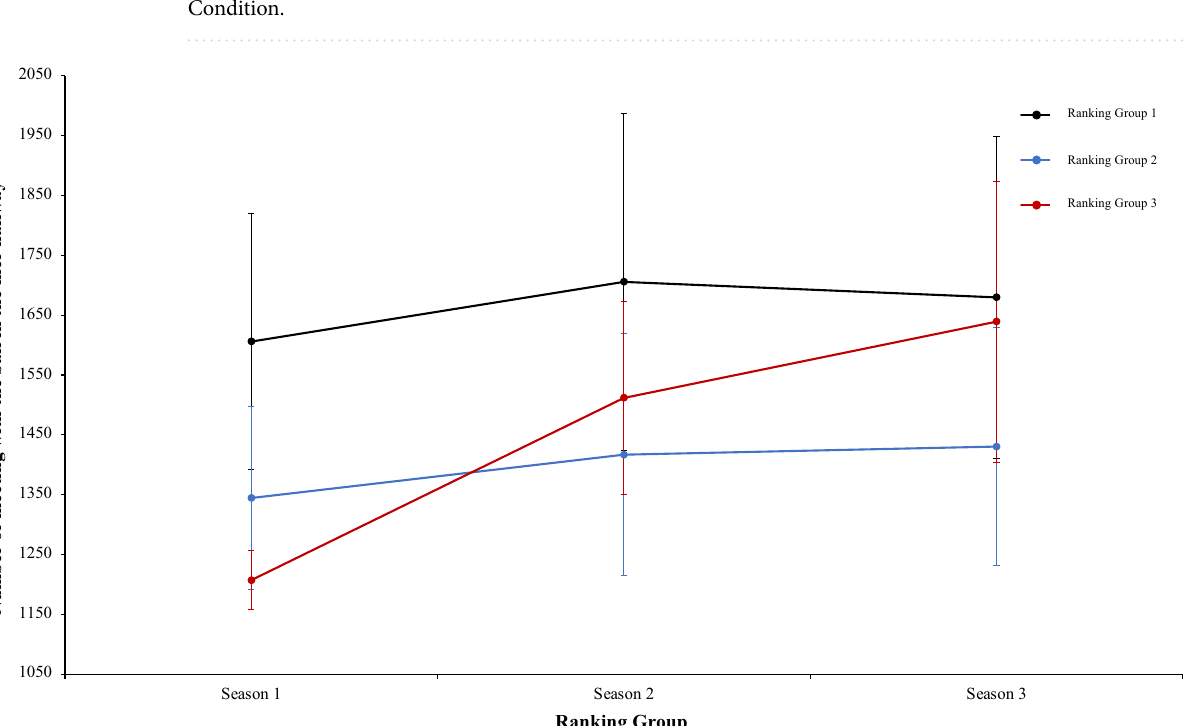
Figure 18. Technical performance. Mean number of meeting with the ball in the inner hallway (± SE) as a funtion of Ranking and Season